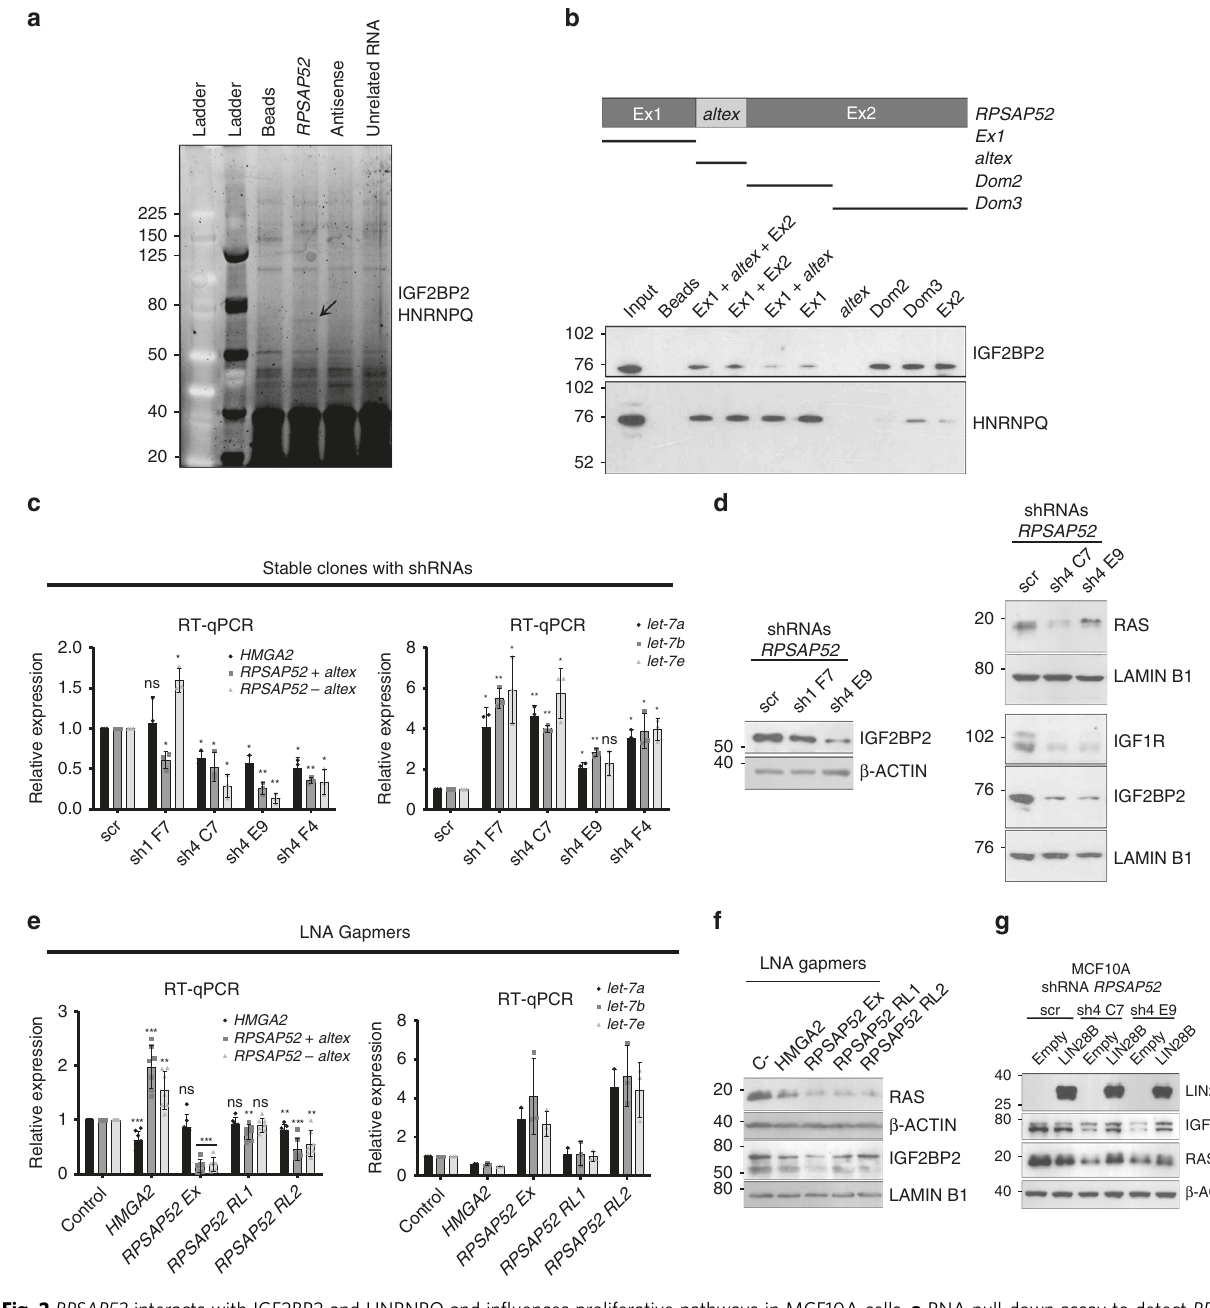
Fig. 2 RPSAP52 interacts with IGF2BP2 and HNRNPQ and in fl uences proliferative pathways in MCF10A cells. a RNA pull-down assay to detect RPSAP52 - associated proteins. In vitro synthesized full-length RPSAP52 transcript (including the alternative exon) or control sequences (the antisense transcript and the unrelated Uc.160 + RNA) were tested. The proteins retrieved were analyzed by SDS-PAGE and the band of ~70 kDa indicated by the arrow was identi fi ed by MS as containing IGF2BP2 and HNRNPQ. b Western blot showing the association between RPSAP52 RNA and IGF2BP2 and HNRNPQ proteins. Different truncated fragments of RPSAP52 RNA (as shown in the upper diagram) were incubated in the presence of MCF10A total protein extracts and the pulled-down material was subject to western blot with speci fi c antibodies. Total extract from the MCF10A cell lines was used as input control, and a reaction without RNA (beads) as negative control. c Stable knockdown of RPSAP52 results in upregulation of let-7 family of miRNAs. Total RNA from MCF10A clones constitutively expressing two different shRNAs against RPSAP52 (sh1 or sh4) was analyzed by RT-qPCR to assess HMGA2 mRNA, RPSAP52 transcripts and let-7 miRNAs levels. Graphs represent the mean ±SD of three independent RNA extractions. Two-tailed student t -test were used (* P < 0.05, ** P < 0.01, ns = not signi fi cant). d Western blot to analyze IGF2BP2, IGF1R, and RAS protein levels upon stable knockdown of